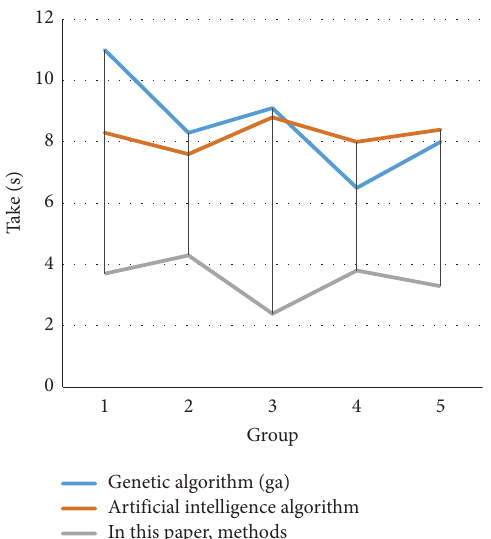
Figure 5: Comparison of average time-consuming results of diferent